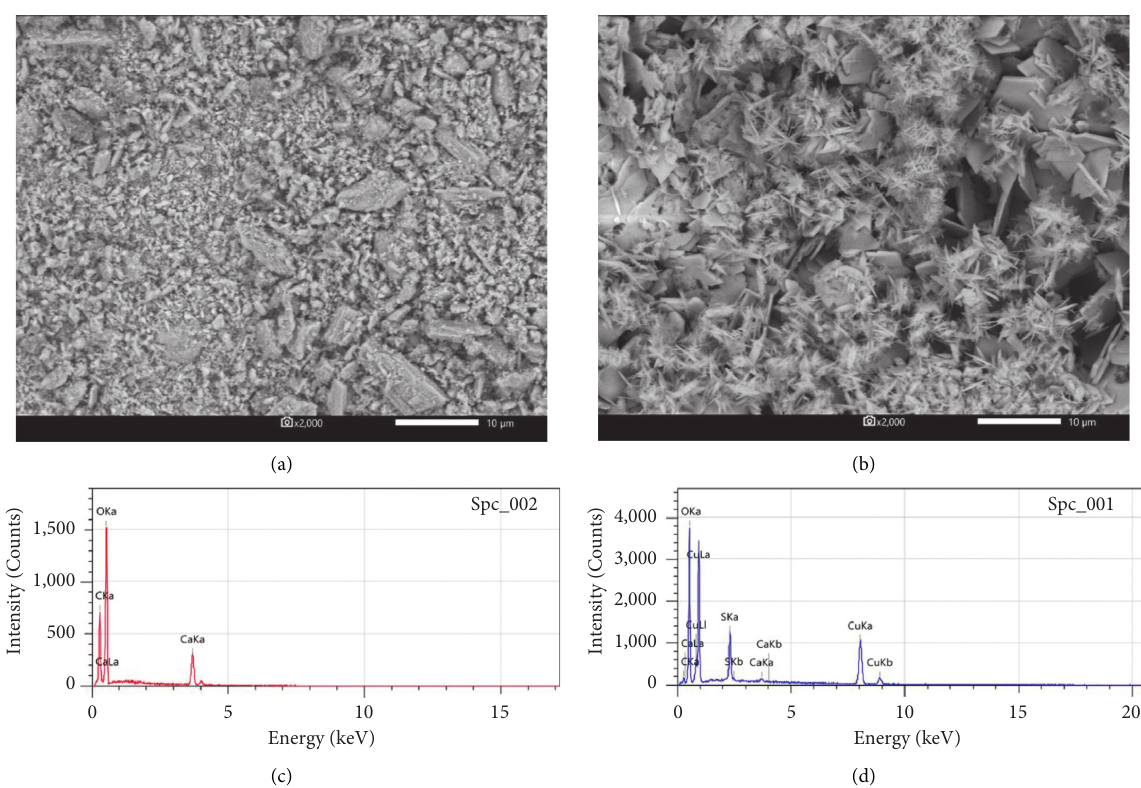
Figure 1: Images of SSP visualized by SEM: (a) raw SSP; (b) Cu(II) loaded SSP. EDX spectral data: (c) raw SSP; (d) Cu(II) loaded